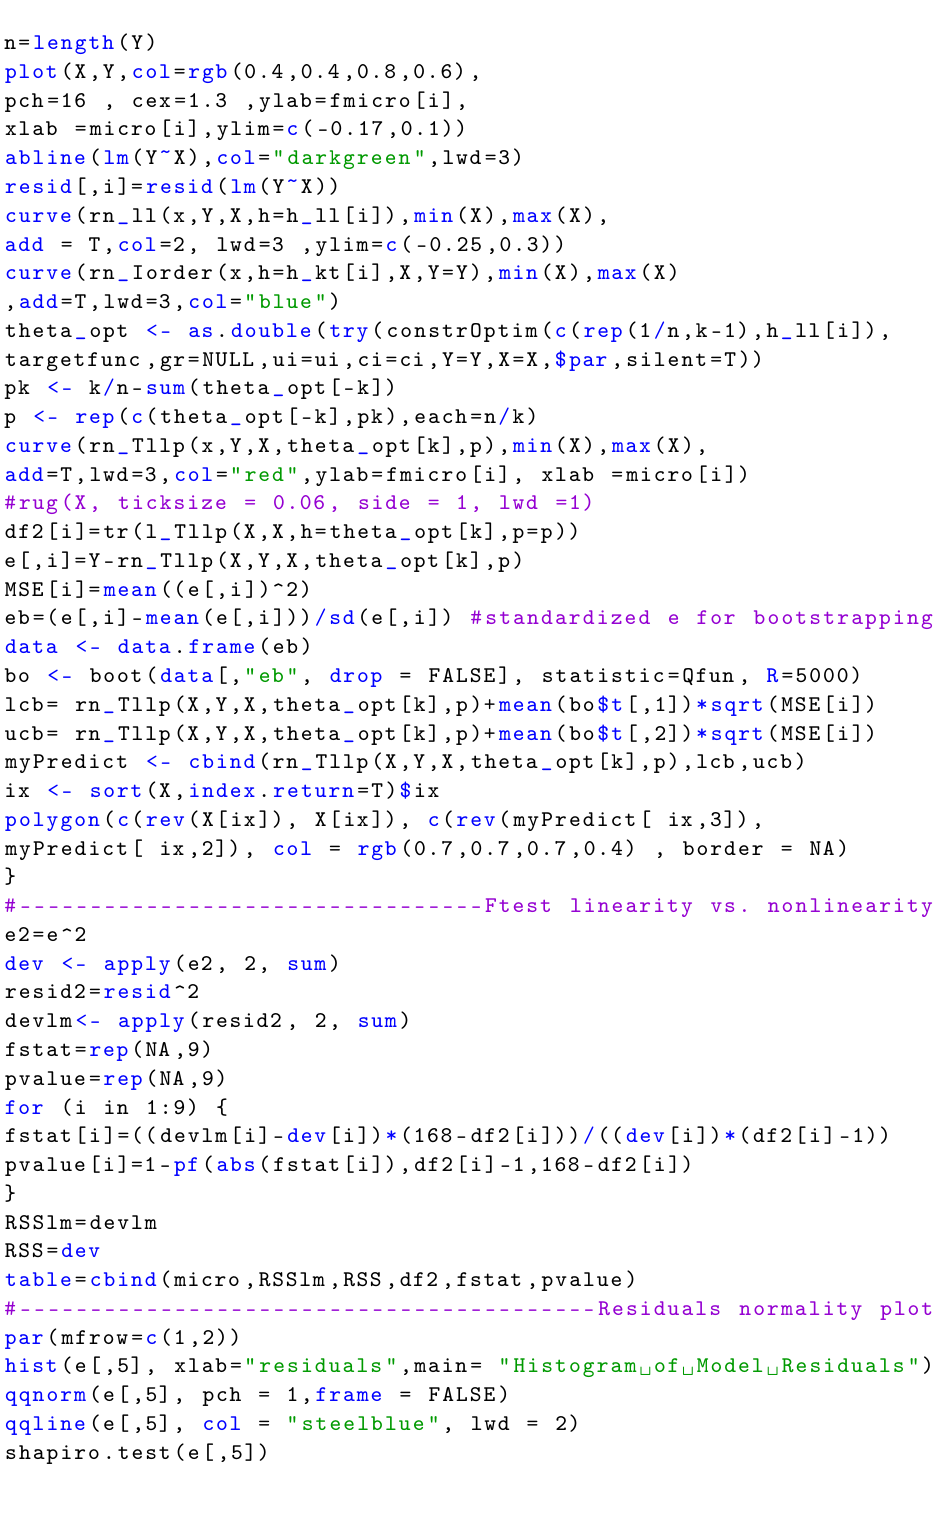
table=cbind(micro ,RSSlm ,RSS ,df2 ,fstat